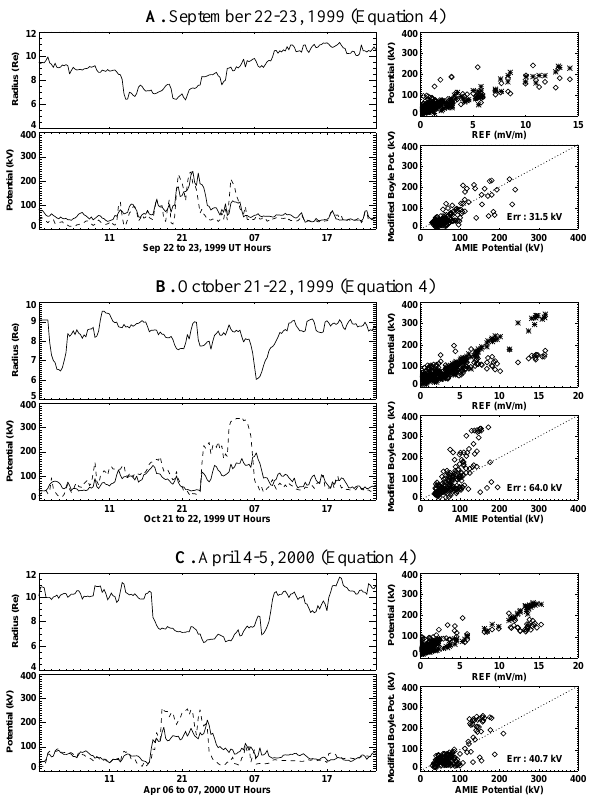
Fig. 6. The same three events in Figure 2, plotted in the same way as Figure 5.